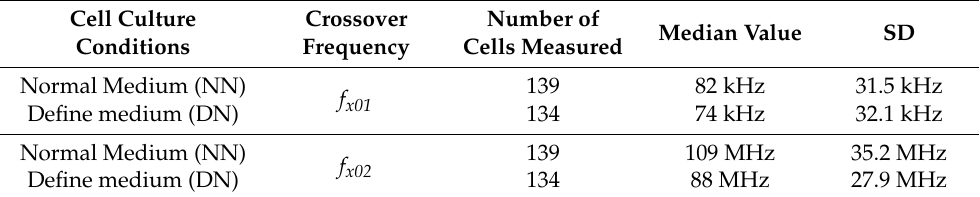
Table 2. Values regarding the crossover frequency measurements of the U87-MG cell line.